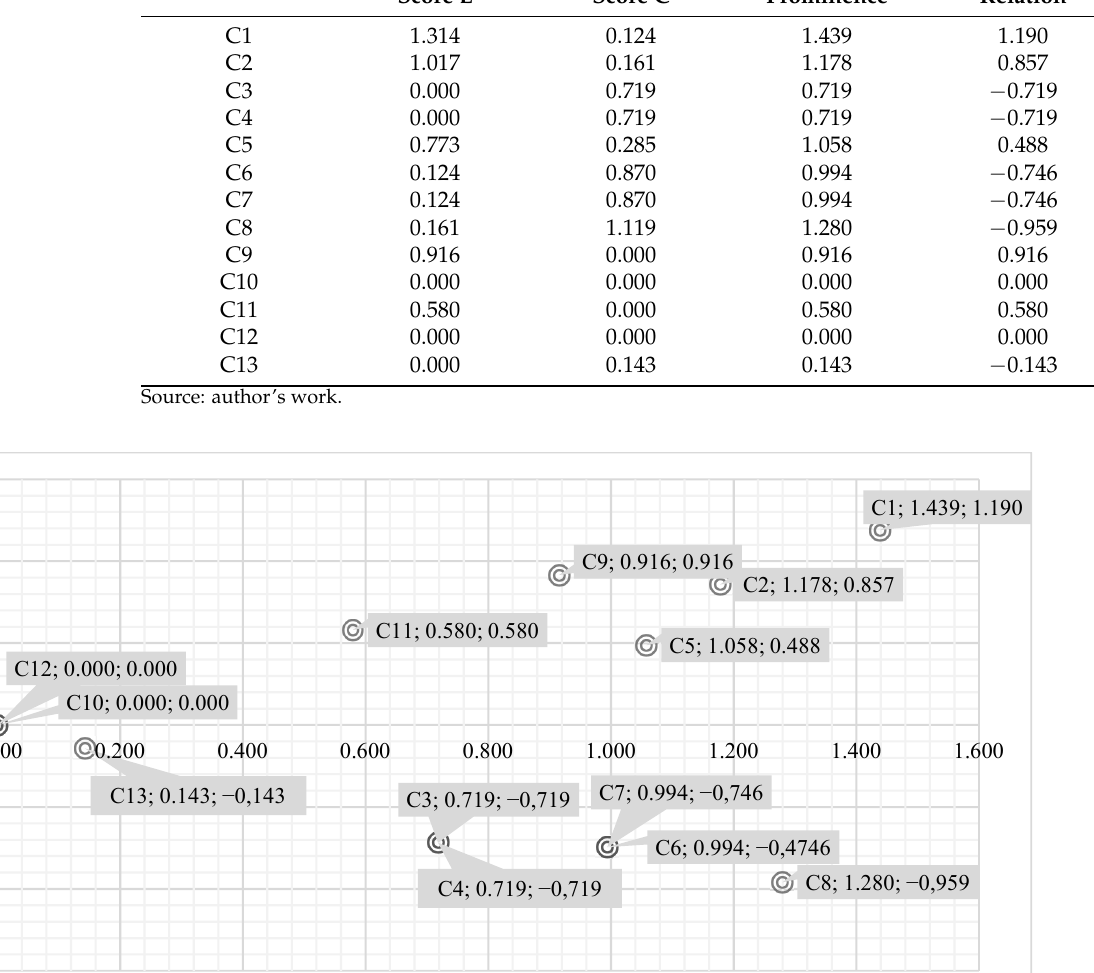
(C3); the number of fungi (lichens) species destroyed (C4); and the number of buildings exposed to excessive noise (C13). Two factors remained neutral (C10 and C12), which may indicate their different nature. The classic DEMATEL method facilitates ordering at the level of decision factors and their analysis regarding their mutual interactions. Therefore, it can be an instrument supporting the selection of factors at the stage of the decomposition of the decision-making